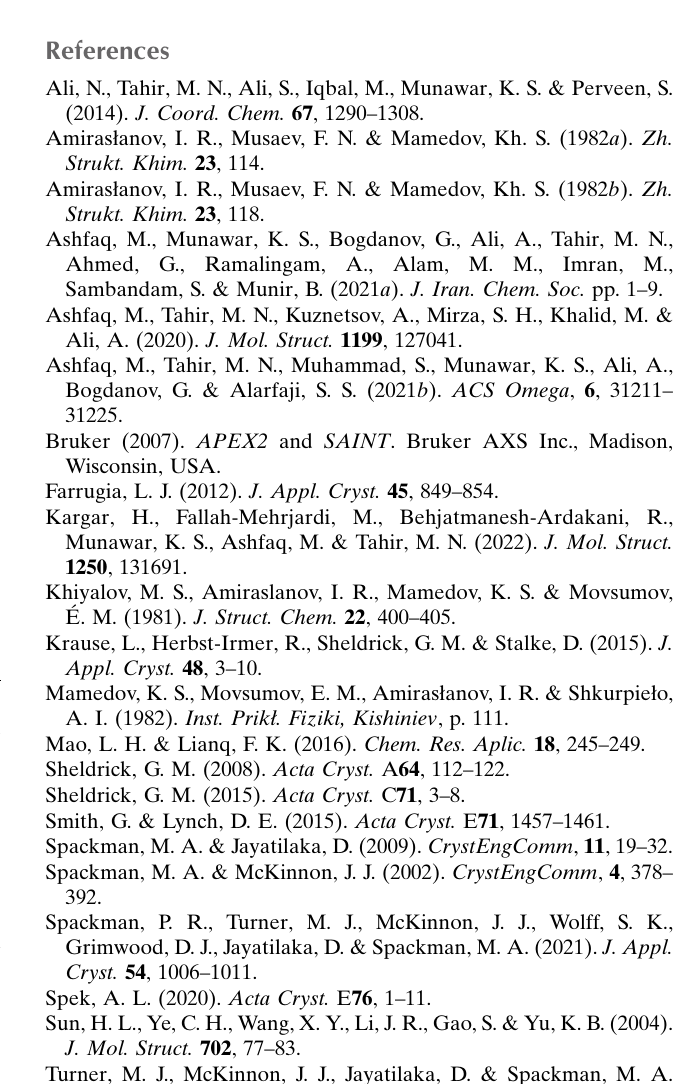
Table 3 Experimental details. Crystal data Chemical